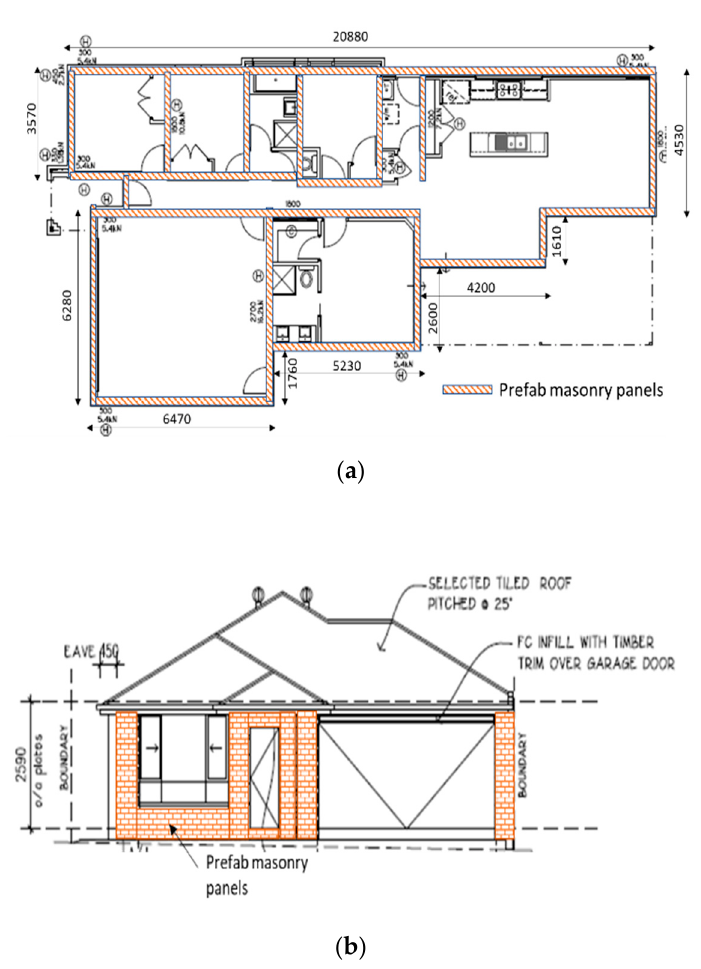
Figure 9. House layout selected for the design and LCE analyses: ( a ) Plan view and ( b ) Elevation view.